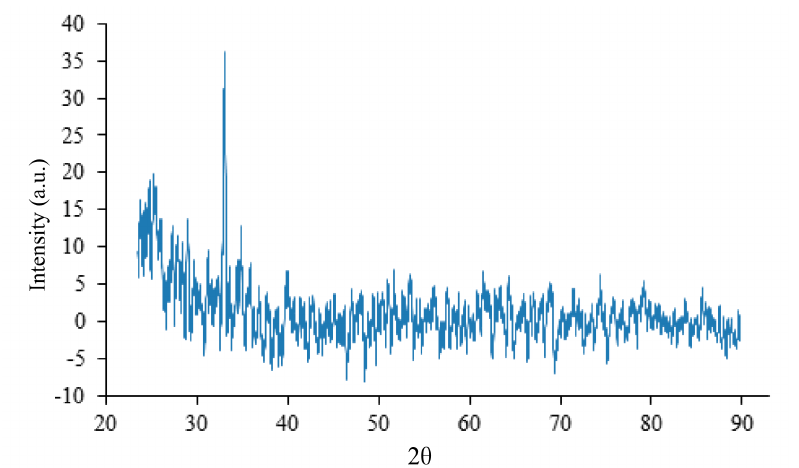
Figure 7. XRD of the sample with the addition of 0.8 mL NH 4 Cl per 100 mL of solution with no annealing.